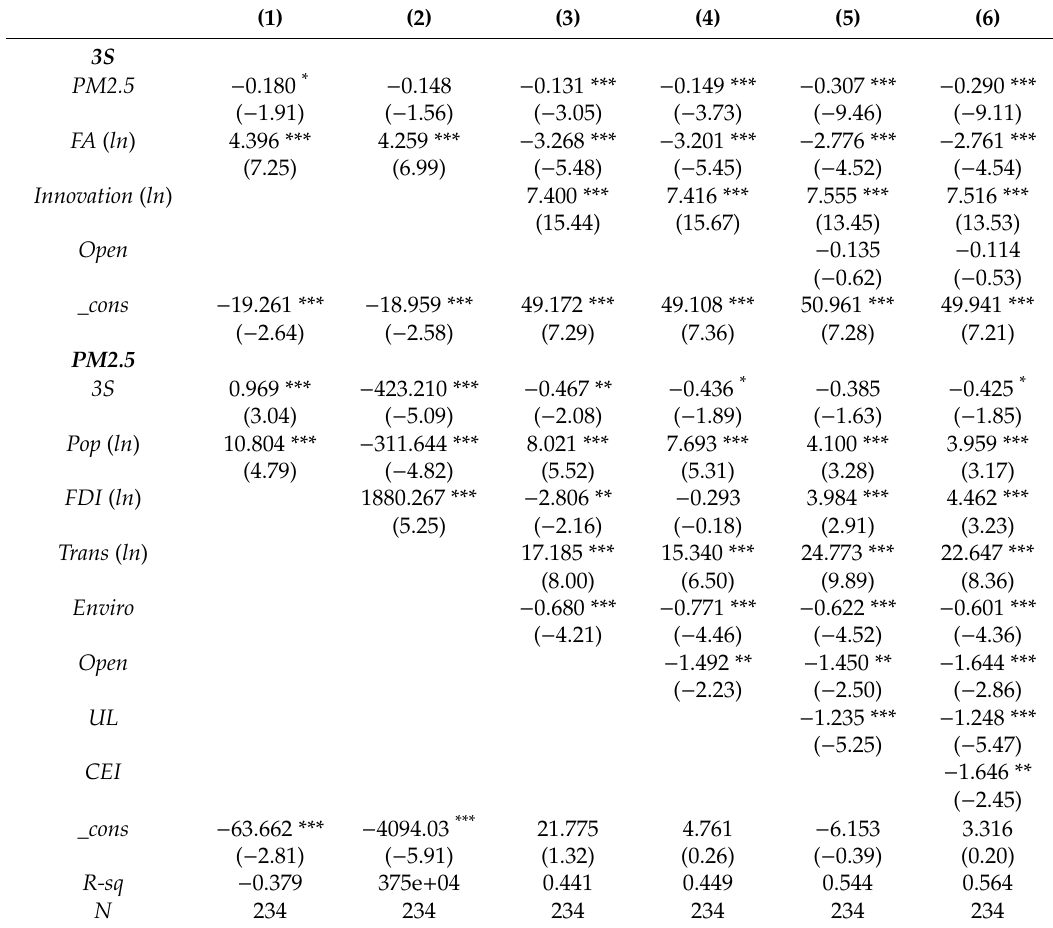
Table 5. Estimated results of the simultaneous equations for tertiary industry and air